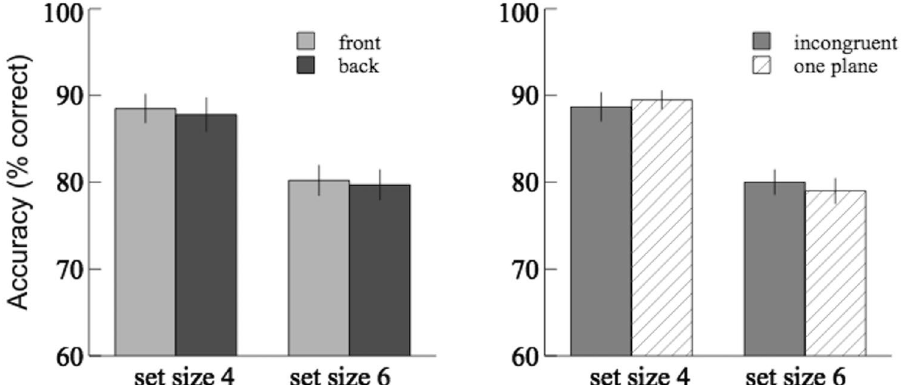
Figure 6. Results of Experiment 4. Comparisons of the average change detection accuracies between the front plane and the back plane were shown on the left; comparisons between the ‘incongruent’ two-planes condition and the control condition were shown on the